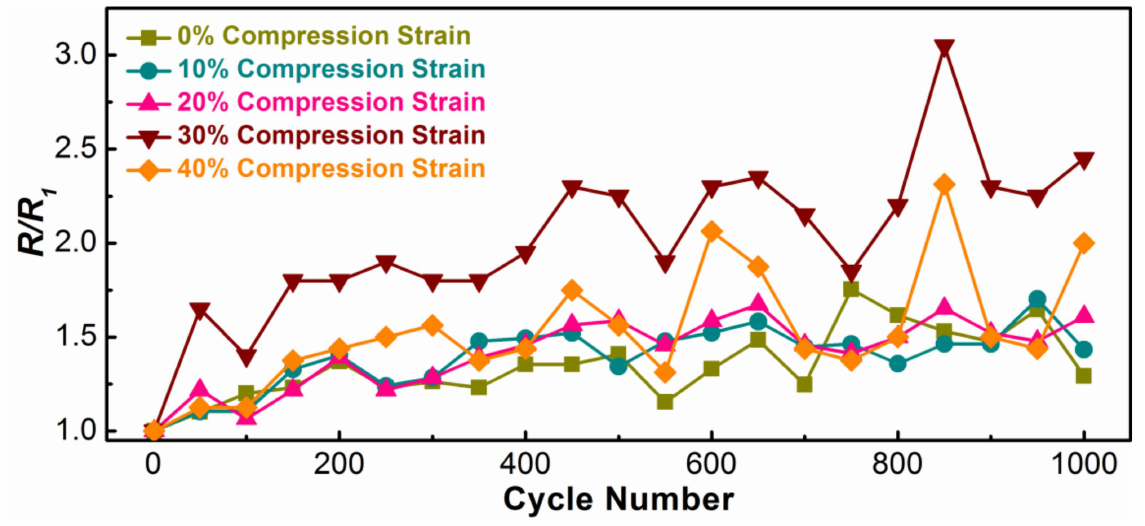
Figure 8. Fatigue tests of compressibility for